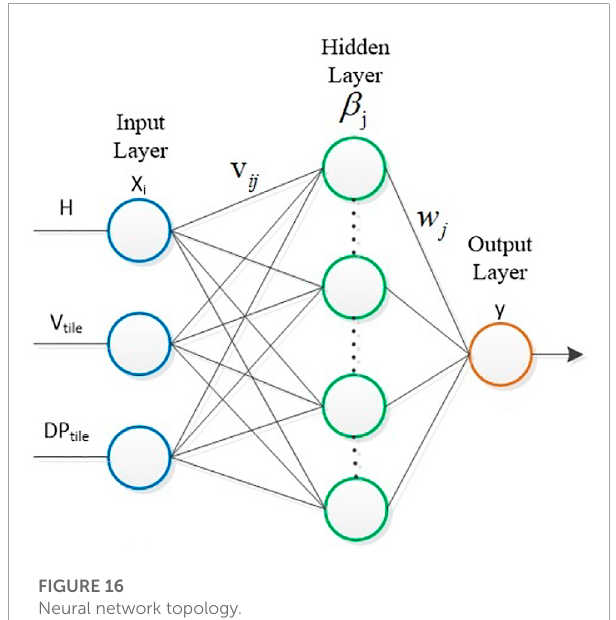
FIGURE 16 Neural network topology. FIGURE 17